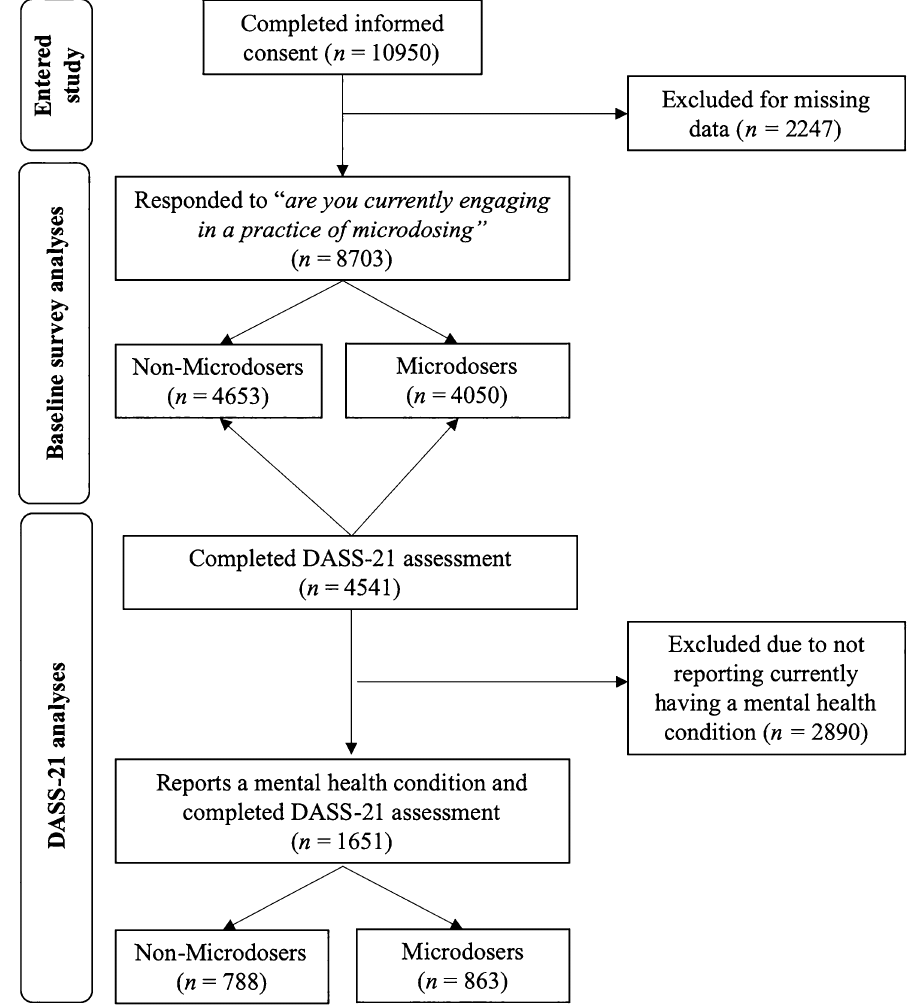
Figure 1. Consort flow chart depicting sample sizes at different levels of